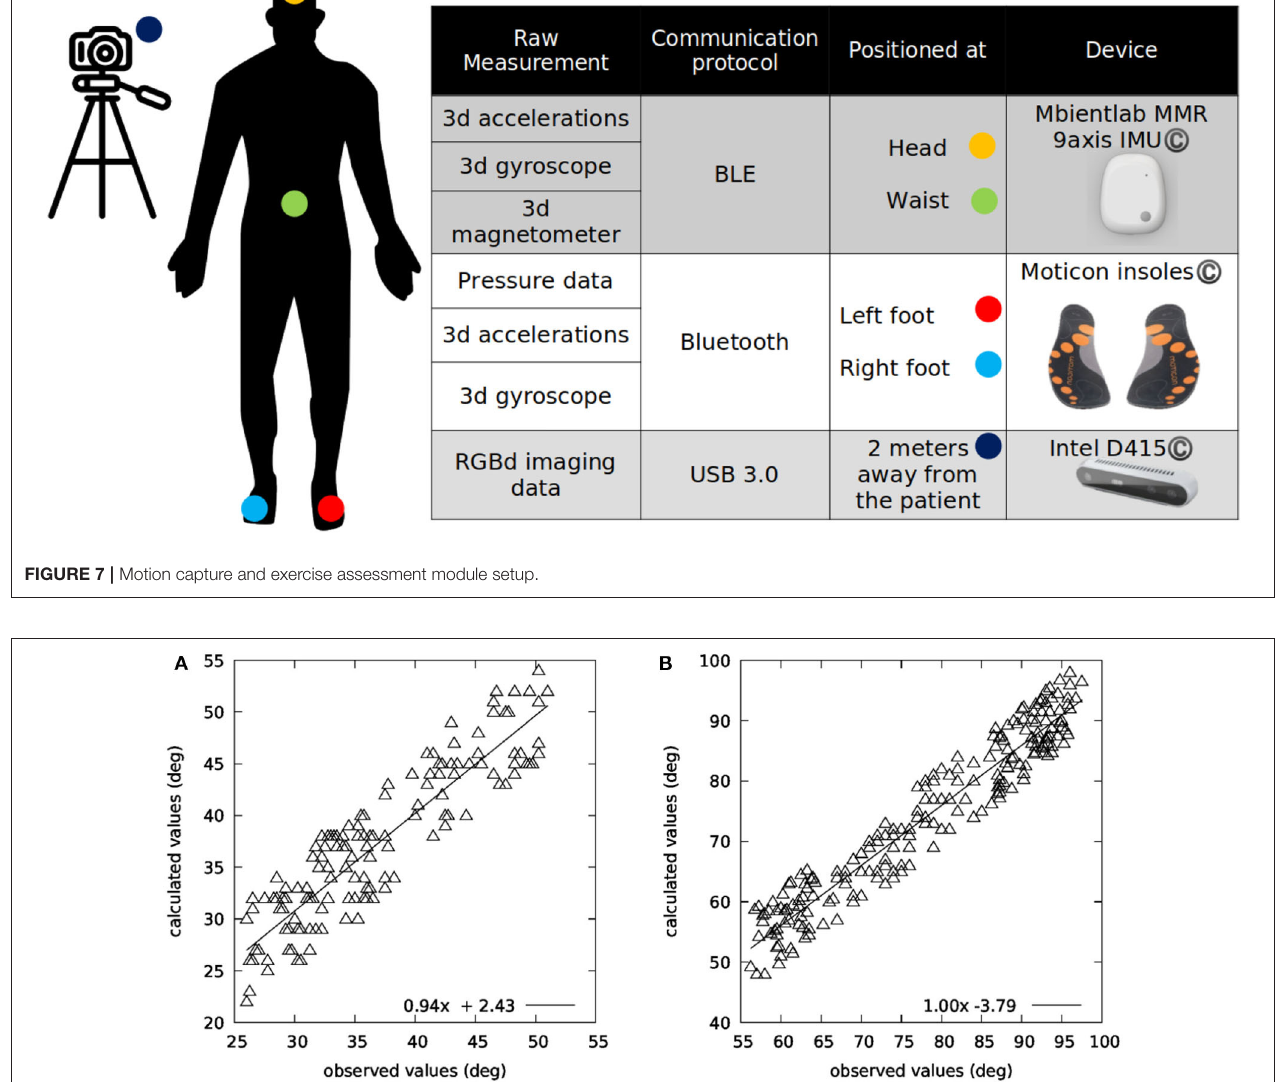
Frontiers in Digital Health |